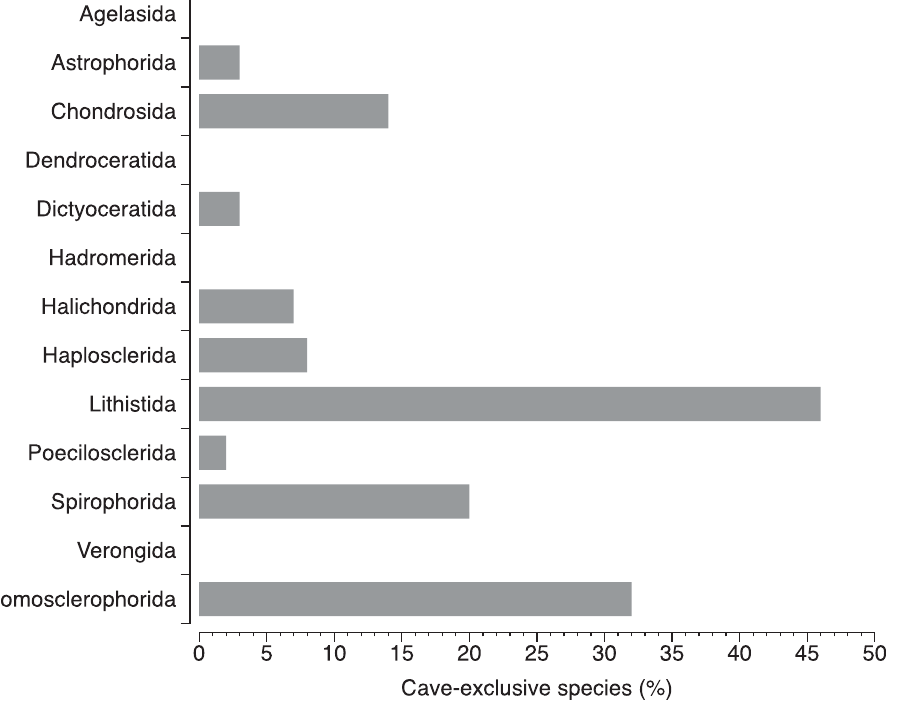
Figure 4. Percentages of cave-exclusive species in the Demospongiae and Homoscleromorpha orders.